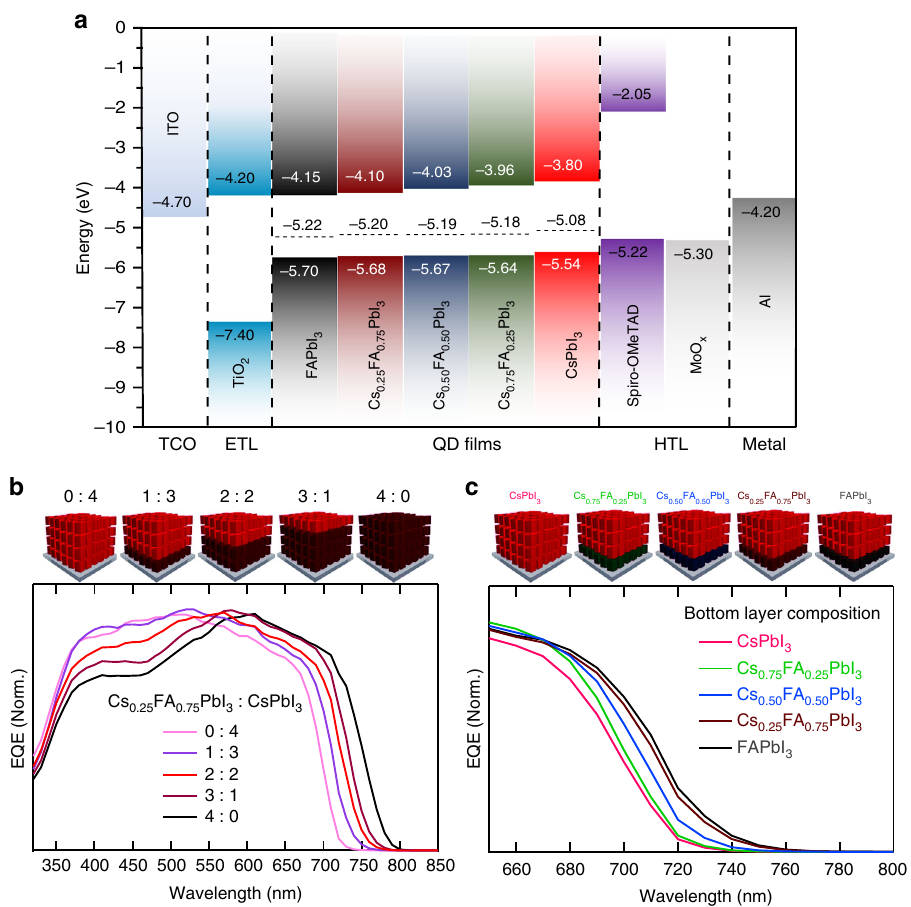
Fig. 2 Optical and electronic properties of perovskite QD heterojunction. a Energy band positions for perovskite QD compositions and contact layers considered in this work. The Fermi level positions (denoted by horizontal dotted lines) and valence-band edges ( E v ) of all perovskite QD fi lms were determined by UPS and XPS, respectively. The conduction band edges ( E c ) were calculated by adding the bandgap energy 26 to E v for the corresponding perovskite QD fi lms. b EQE spectra of solar cells with varying thickness ratio of the Cs 0.25 FA 0.75 PbI 3 layer to CsPbI 3 layer in the perovskite QD absorber. c EQE spectra of solar cells with different compositions of the bottom layer in the perovskite QD absorber where the thickness ratio of the mixed-cation Cs x FA 1 – x PbI 3 QD layers to CsPbI 3 QD layers is 1:3 in all